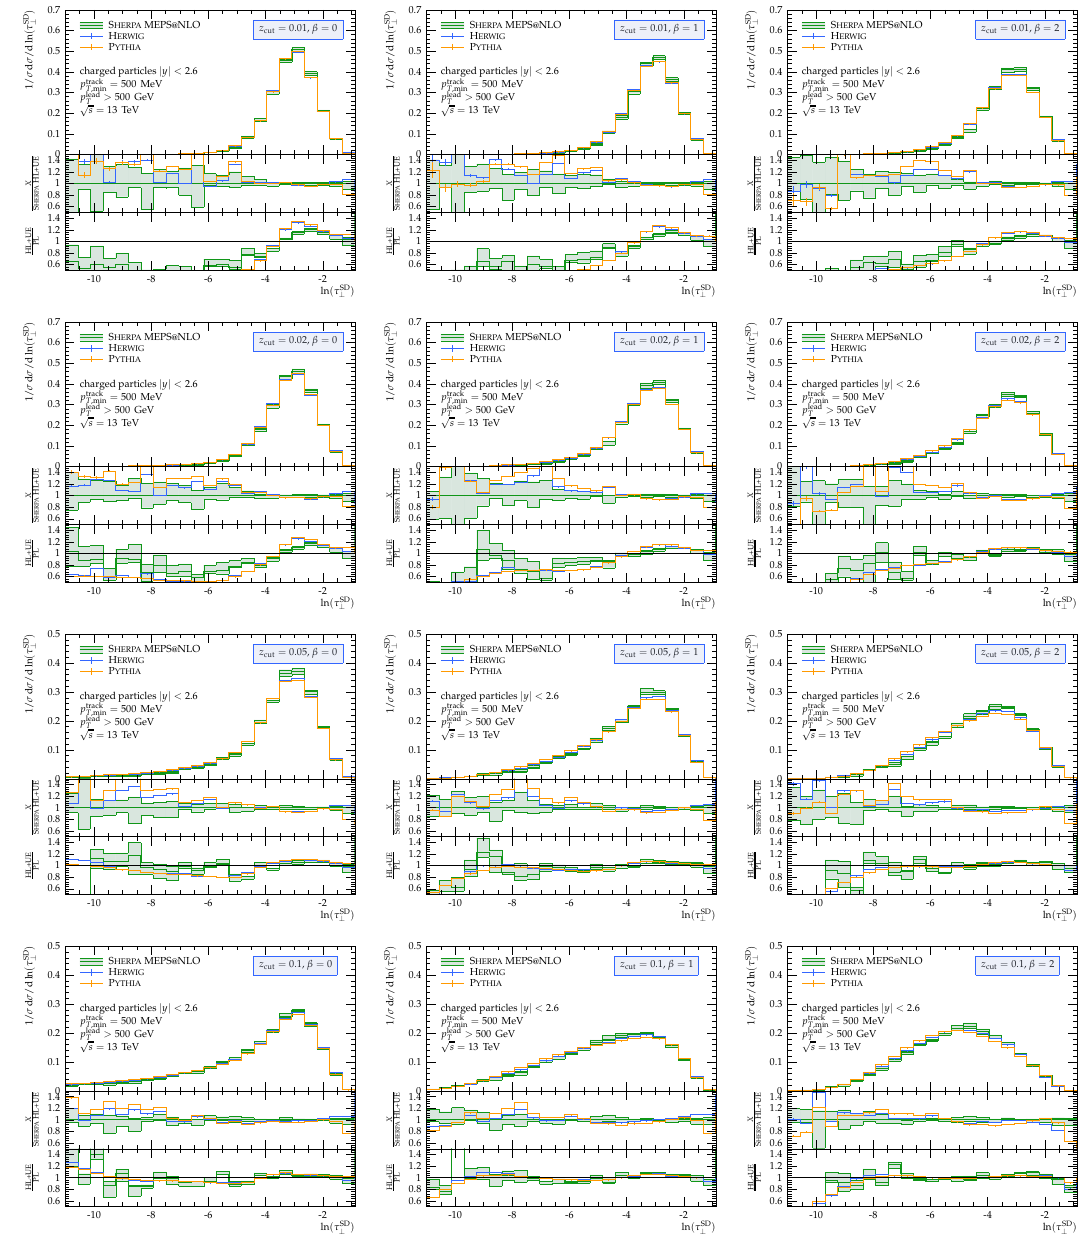
Figure 16 . Same as figure 15 but for the p T, min = 500 GeV event selection and z cut ∈ { 0 . 01 , 0 . 02 , 0 . 05 , 0 . 1 }